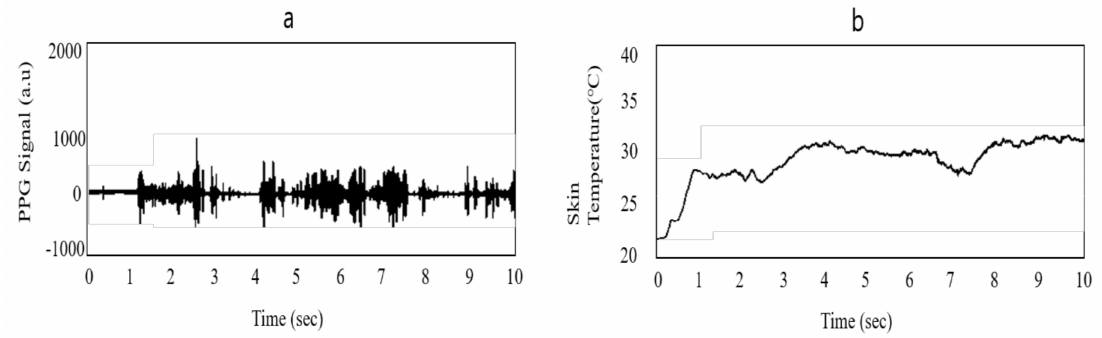
Figure 5. Raw form of signals from the PWB-300: ( a ) PPG signal and ( b ) skin temperature signal.